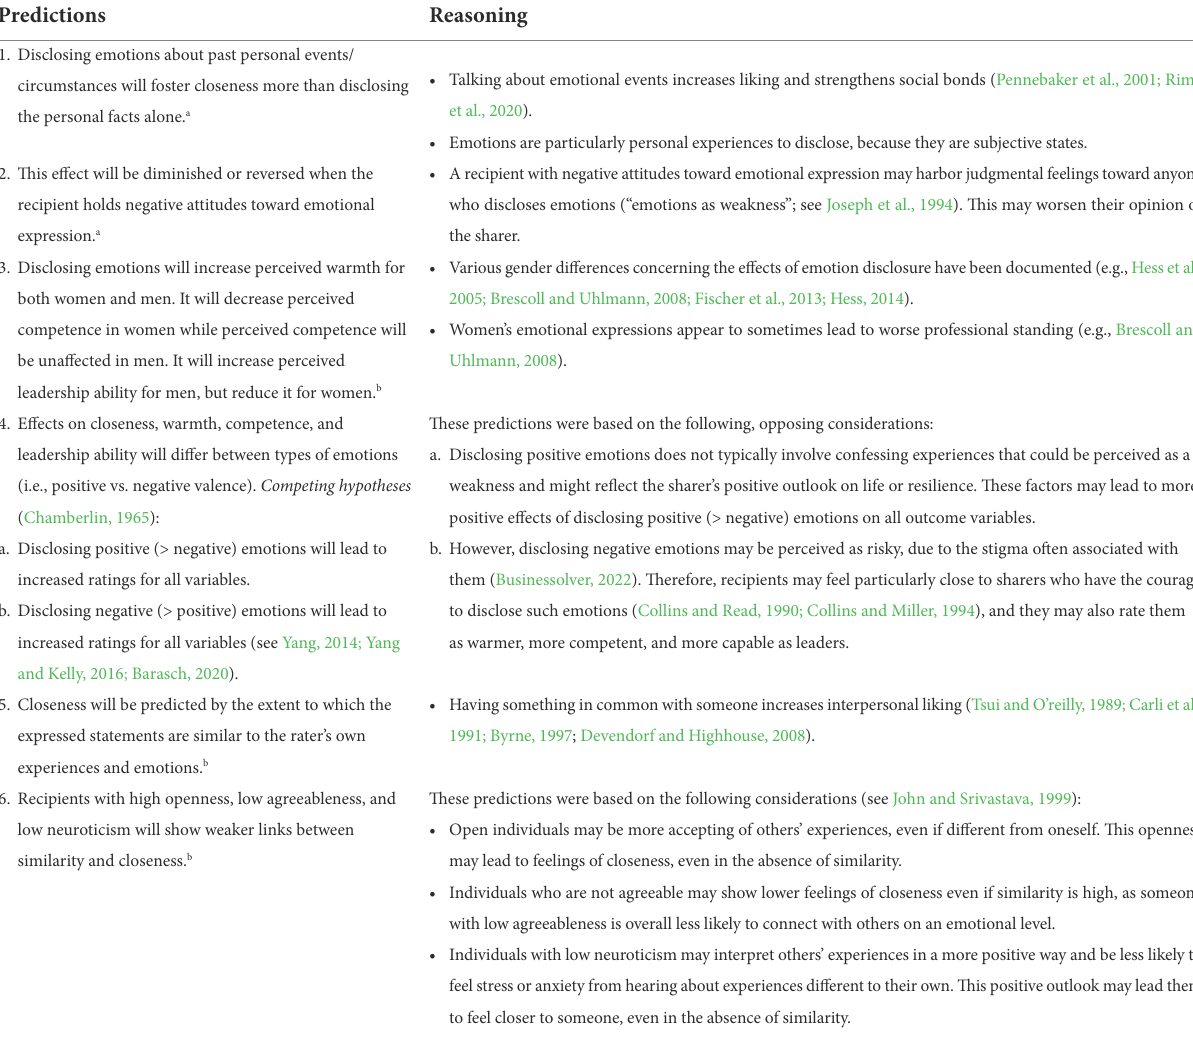
TABLE 1 Pre-registered hypotheses. Predictions